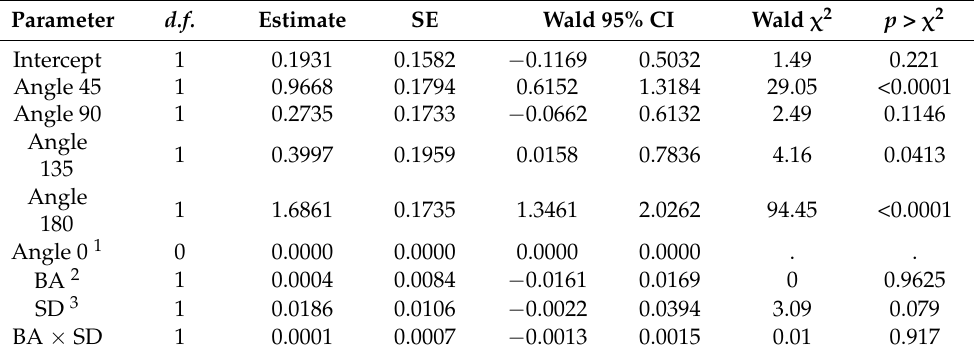
Table 3. Parameter estimates for generalized linear model results of synthetic bat echolocation playback response within an anechoic chamber to detector angle ( ◦ ) and simulated clutter variation represented by basal area (m 2 /ha) and stem density (stem count) for minimum frequency (Fmin), Blacksburg, VA, USA, 2016. Detectors recorded in full spectrum (see text for details). Parameter d.f.